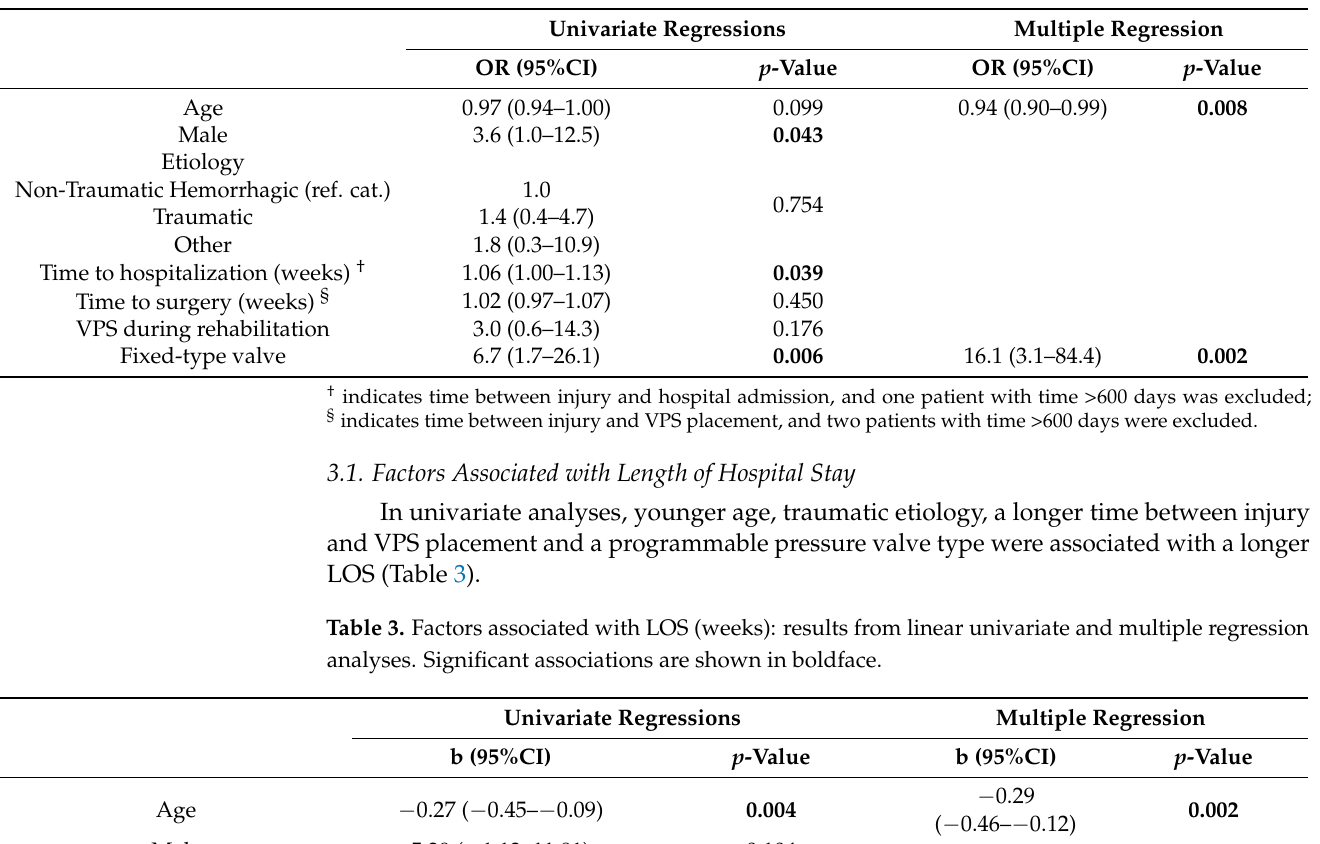
Table 2. Factors associated with VPS complications: results from logistic univariate and multiple regression analyses. Significant associations are shown in boldface.